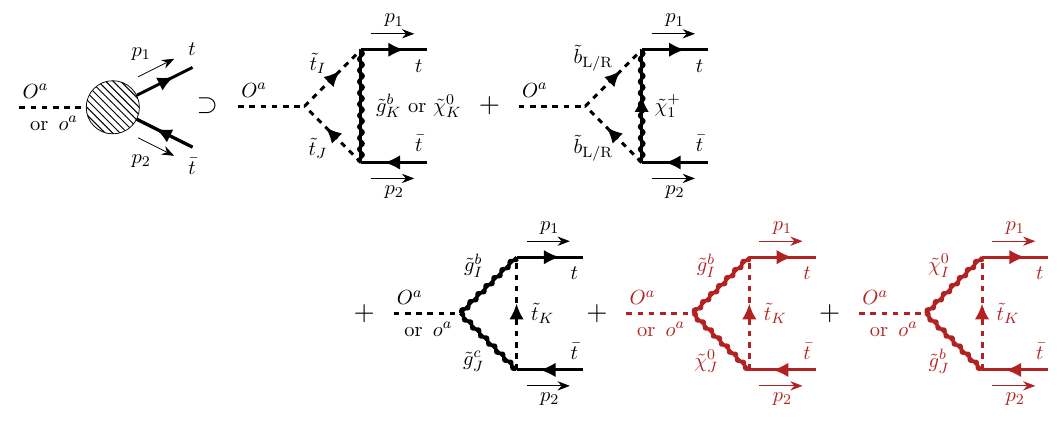
Figure 3. Representative diagrams for scalar or pseudoscalar sgluon decays to top-antitop pairs. Not all diagrams contribute to the pseudoscalar decay. Red diagrams vanish if R symmetry is